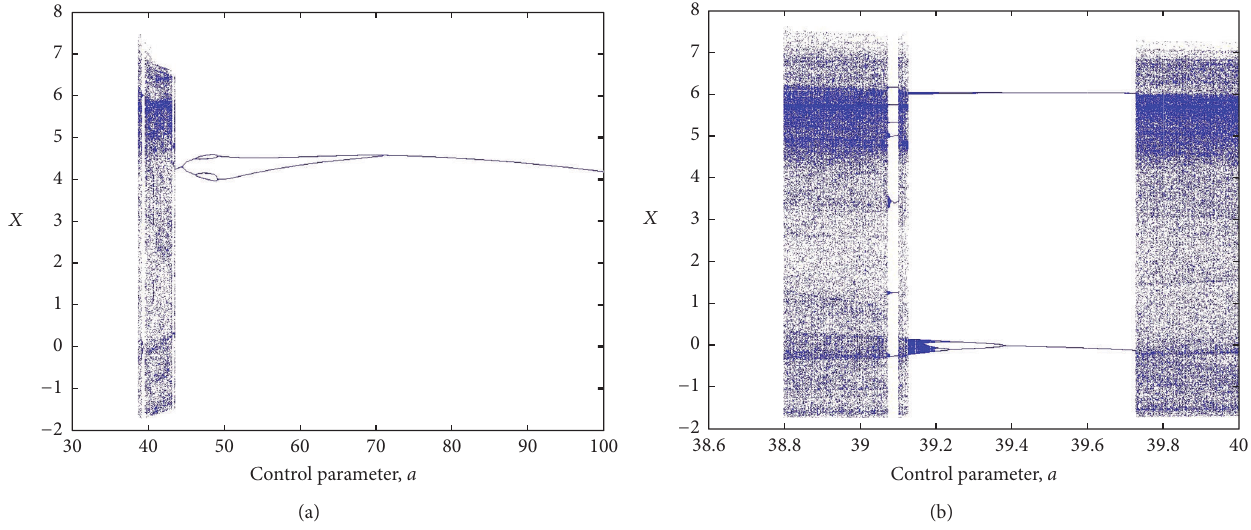
Figure 7: Bifurcation diagram using 𝑎 as control parameter. Parameters: {𝑏 = 2 , 𝑐 = 3 , and 𝑑 = 2}